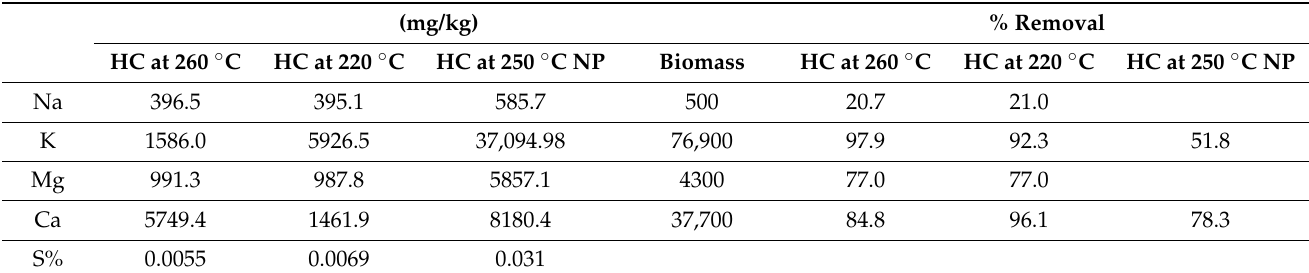
Table 2. Metal concentrations in biomass and three HCs including % removal.